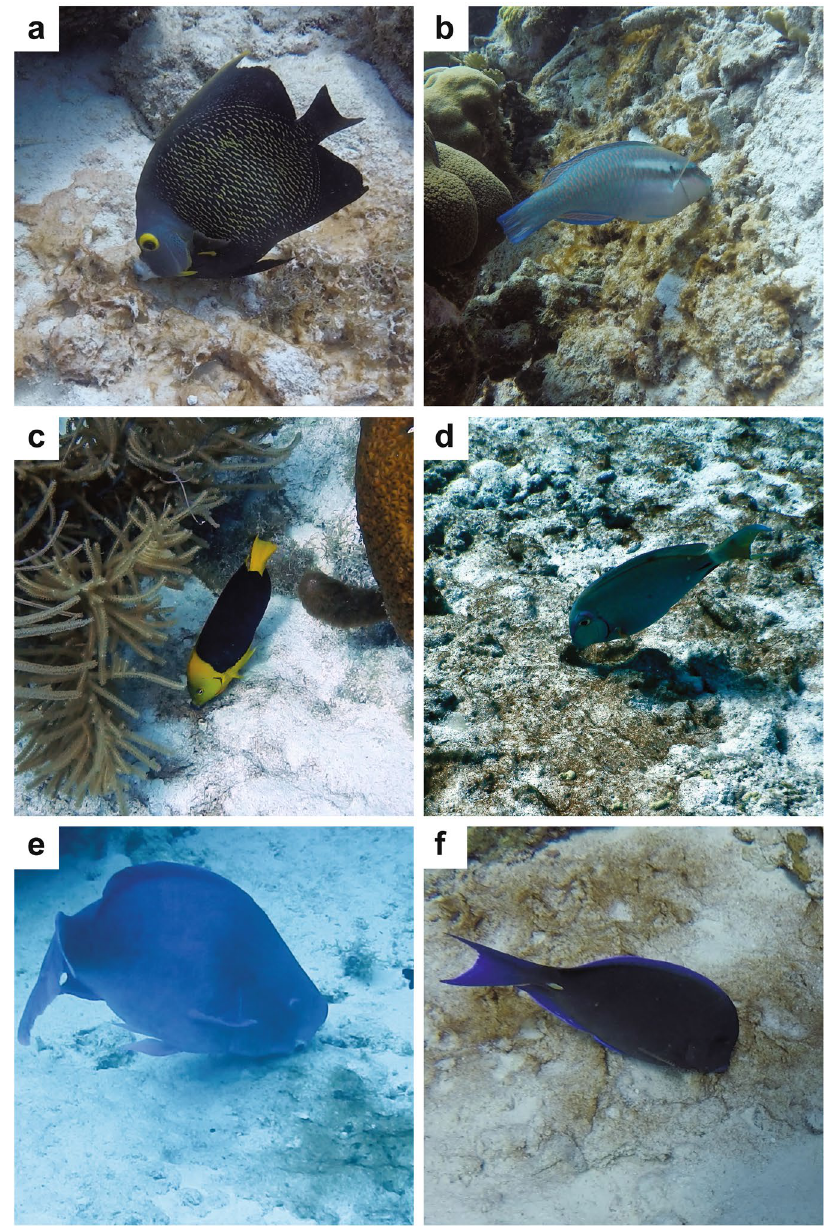
Figure 1. Reef fishes observed grazing on benthic cyanobacterial mats in Bonaire. ( a ) French Angelfish ( P . paru ). ( b ) Striped Parrotfish ( S . iseri ). ( c ) Rock Beauty ( H . tricolor ). ( d ) Ocean Surgeonfish ( A . bahianus ). ( e ) Blue Parrotfish ( S . coeruleus ). ( f ) Atlantic Blue Tang ( A . coeruleus